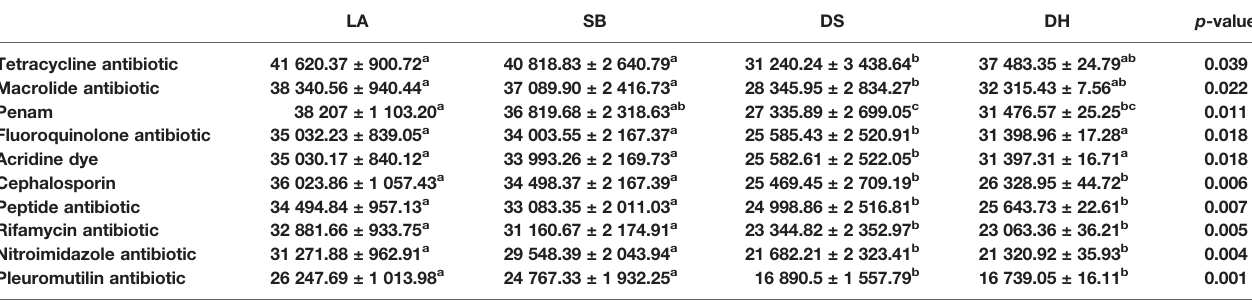
TABLE 3 | Comparison of abundance of the different types of antibiotic resistance genes. LA SB DS DH p